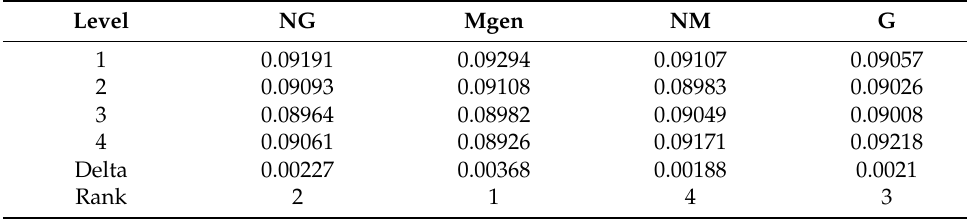
Figure 7. The graph of parameter change trend.